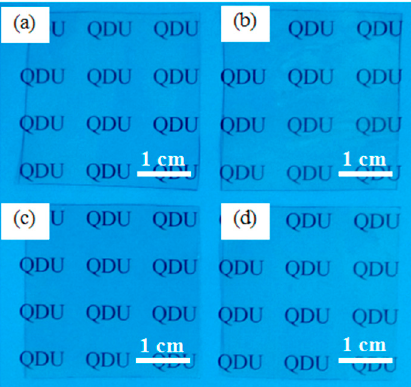
Figure 2. The digital photos of ( a ) shrinking pristine film, ( b ) M 1 -1, ( c ) M 2 -1, and ( d ) M 3 -1.